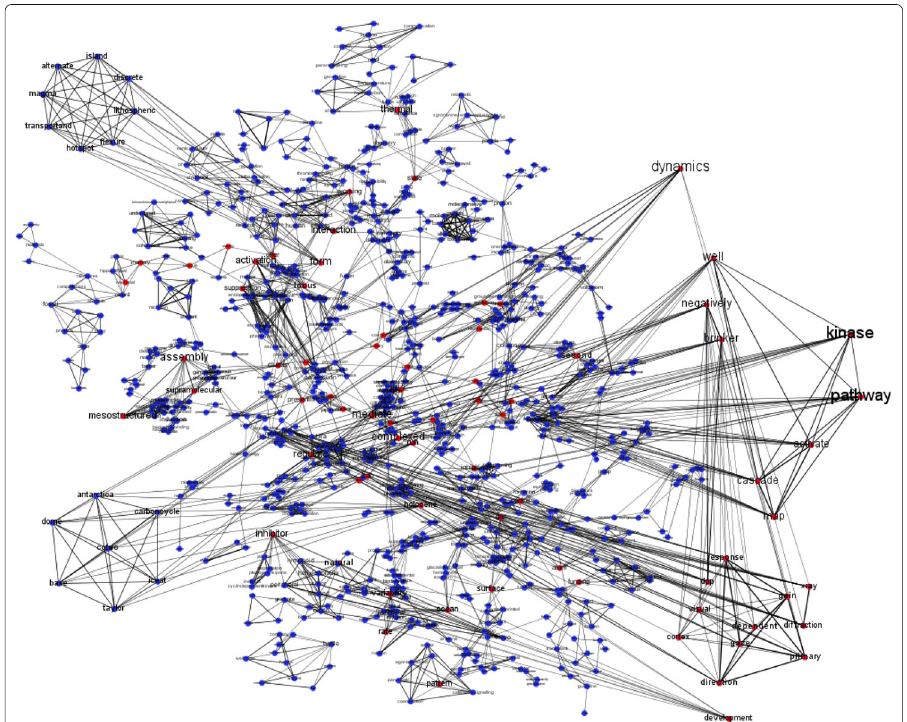
Fig. 2 Critical network for the Nature TVSNT, w 8,1 in t =